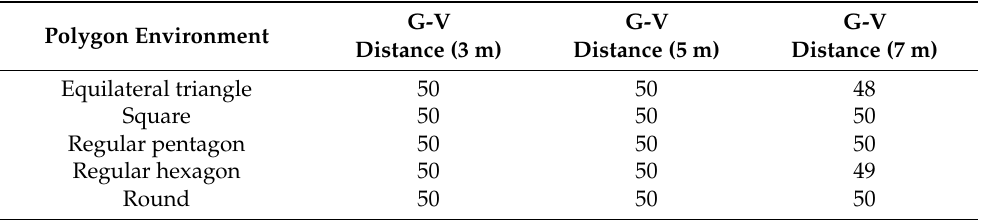
Figure 6. Turtlebot3_burger in a square environment. ( a ) Simulation environment includes turtlebot3_burger and turtle- bot3_square model, red arrow as X axis, green arrow as Y axis, and blue arrow as Z axis. ( b ) Discrete points collected by rangefinder sensor from center point to square walls. Table 1. Correct recognition number of times in different symmetrical polygons (number of experi- ments in each environment =